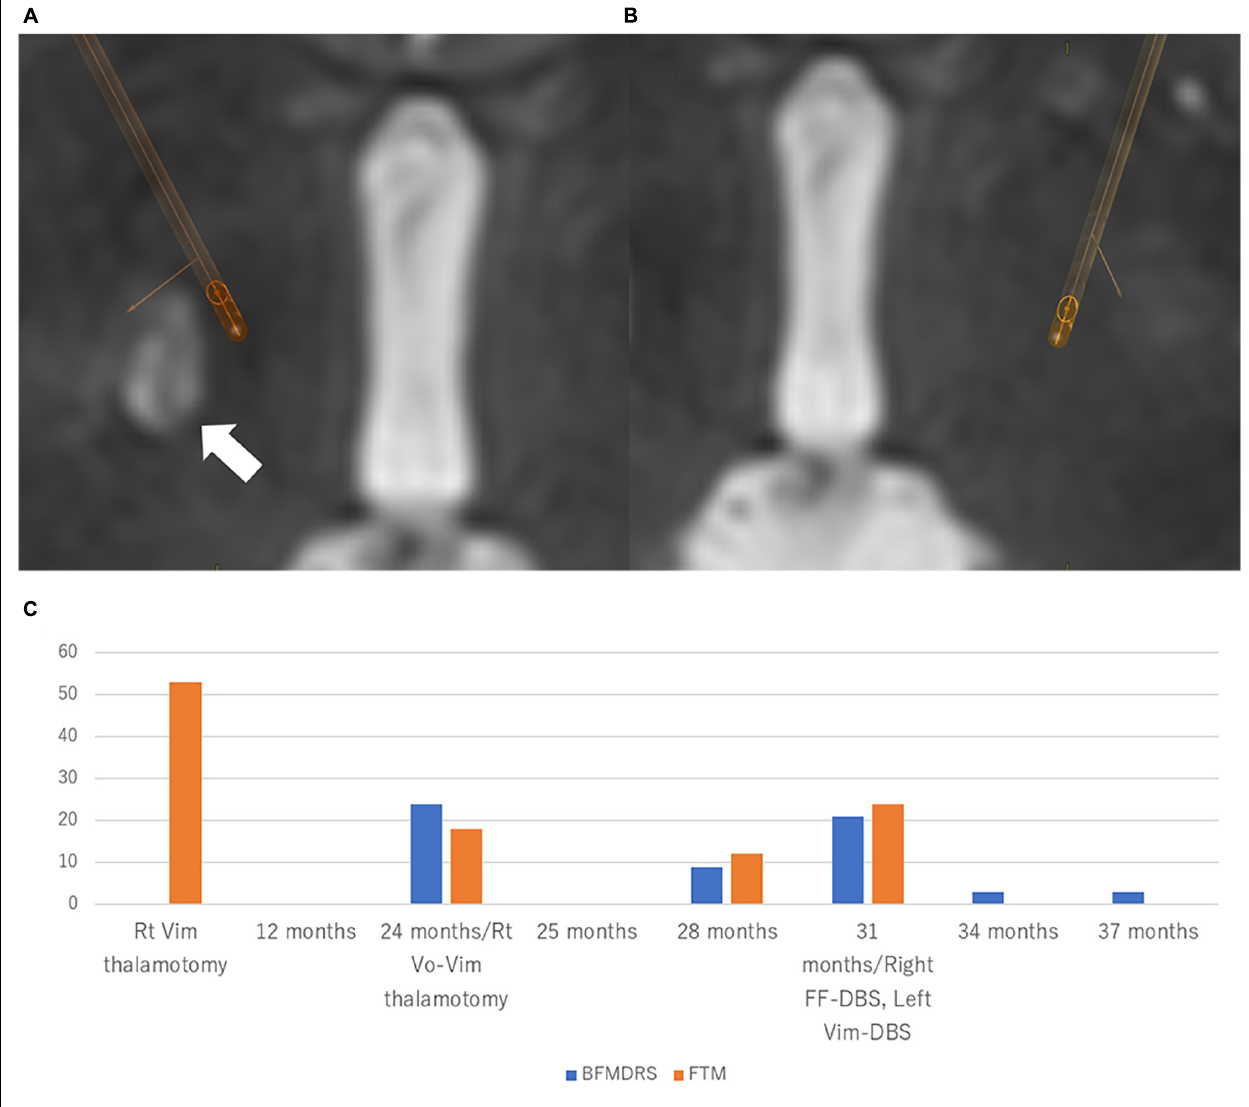
FIGURE 2 | Location of the electrodes and clinical course in Case 2 Patient. The electrodes were simulated by Brainlab elements using postoperative CT scan fused with preoperative T2-weighted MRI. (A) Right-side stimulation: 13-(24%)/14-(23%)/15-(23%)/16-(30%)/C +, 130 µ s, 179 Hz, 2.0 mA. (B) Left-side stimulation: 2-(20%)/3-(20%)/4-(20%)/5-(14%)/6-(13%)/7-(13%)/C +, 130 µ s, 179 Hz, 2.0 mA. White arrow indicates the lesions of pallidotomy. Directional DBS electrodes (Boston Scientific, Marlborough, MA, United States) were used. (C) The patient experienced a 73.0% improvement of BFMDRS at 6 months after the bilateral Forel’s field DBS. BFMDRS, Burke-Fahn-Marsden dystonia rating scale (range: 0–120). DBS, deep brain